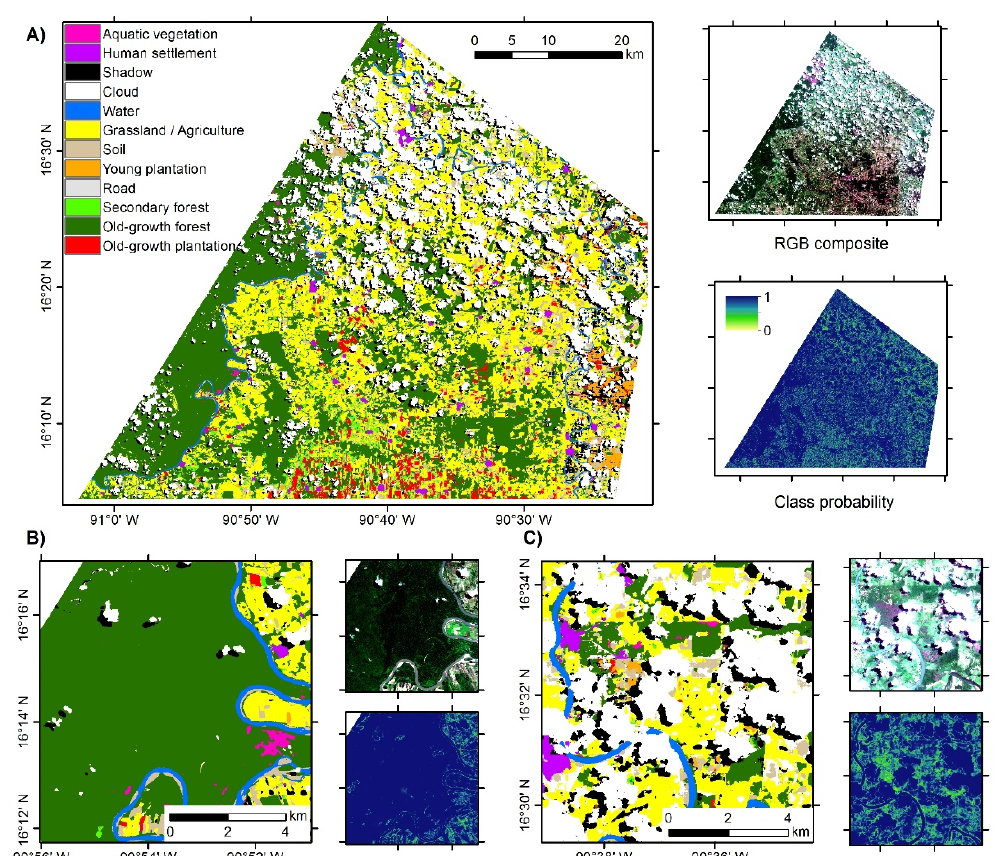
Figure 5. ( A ) Complete study area land use/land cover (LULC) classification using the MS + SAR U-net, along with its corresponding RGB composite and class probability maps. ( B ) Example of old-growth forest dominated areas with high class probability. ( C ) Example of areas with clouds and shadows that were recently cleared with low class probability.